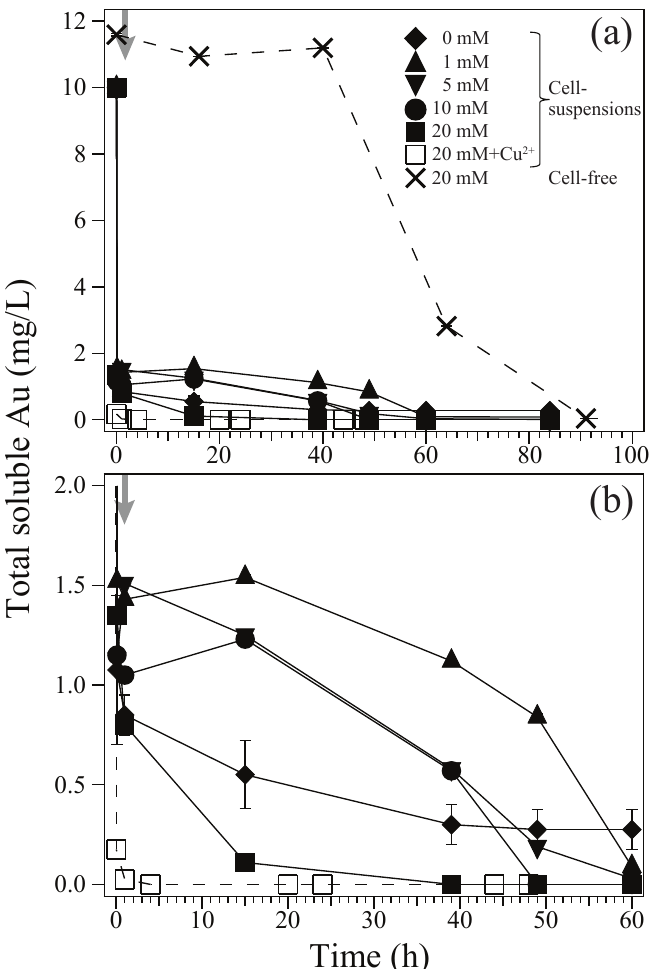
Figure 1. Au(III) biosorption and bioreduction in cell-suspensions of Ac. aromatica (pH 2.5). ( a ) Di ff erent initial concentrations of formate were used as e-donor; (cid:95) 0 mM, (cid:78) 1 mM, (cid:72) 5 mM, 10 mM, and (cid:4) 20 mM (solid lines). As a potential enzymatic inhibitor, 5 mM Cu 2 + was added with 20 mM formate ( (cid:3) ; dotted line). Cell-free controls with 20 mM formate ( × ; dotted line) were also tested. ( b ) shows the same data on an enlarged x and y -axis. Grey arrows indicate the time of formate addition at 1